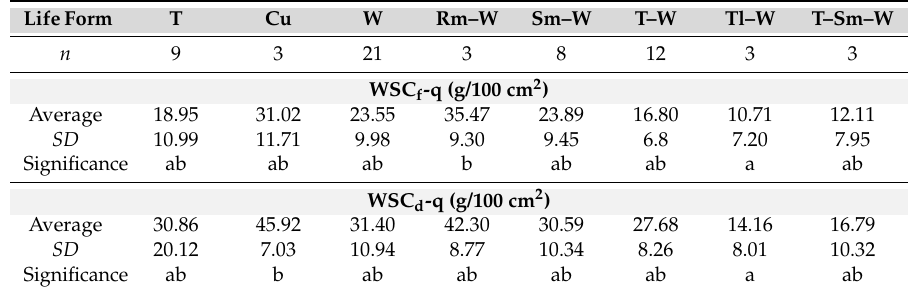
Table 2. Water storage capacity of bryophyte communities at the quadrat scale (100 cm 2 ) among life form